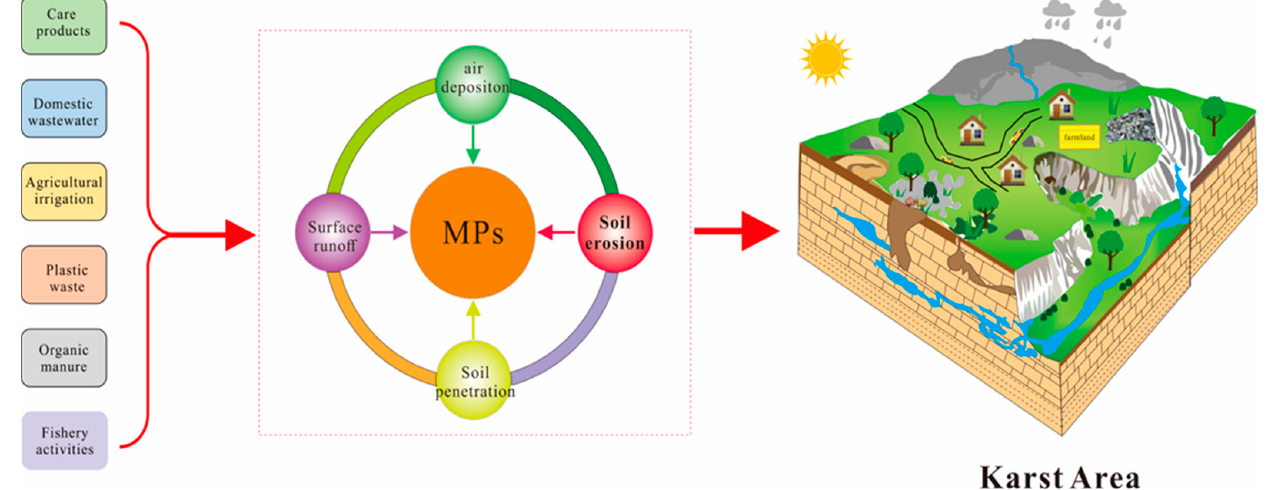
Figure 7. Schematic diagram of the main sources of MPs in karst groundwater.